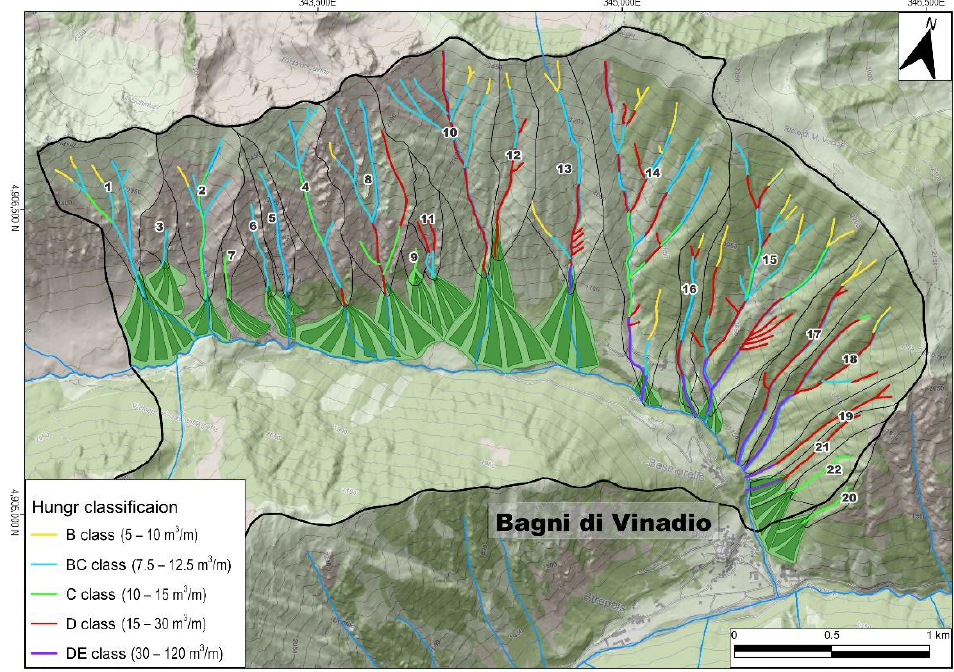
Figure 10. Subdivision of the secondary catchment areas of the sub-basins according to the potential debris production (expressed in cubic meters of debris per linear meter), according to the Hungr method [61].